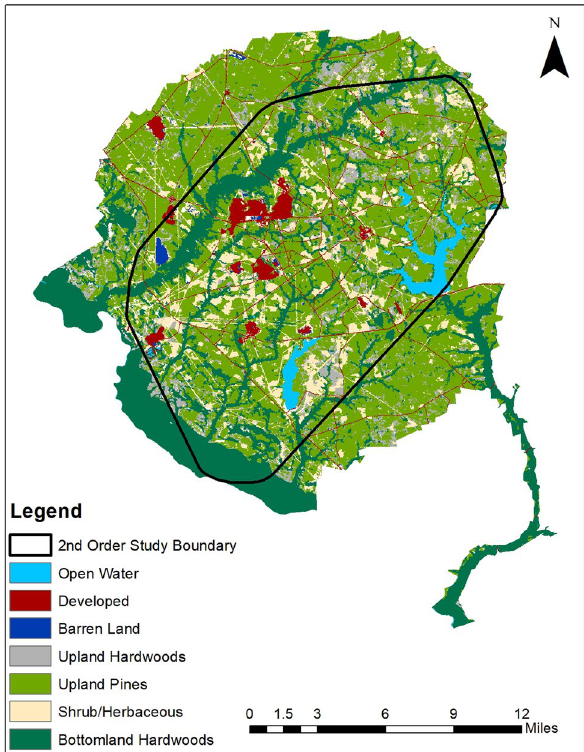
Figure 1. Overall study area with distinct vegetative communities and the 1.2 km 2 polygon representing the specified area used to develop available locations for second order resource selection functions of male and female wild pigs ( Sus scrofa ) during two distinct seasons (i.e., low-forage and high forage) between Janurary 2014–December 2019 in South Carolina,